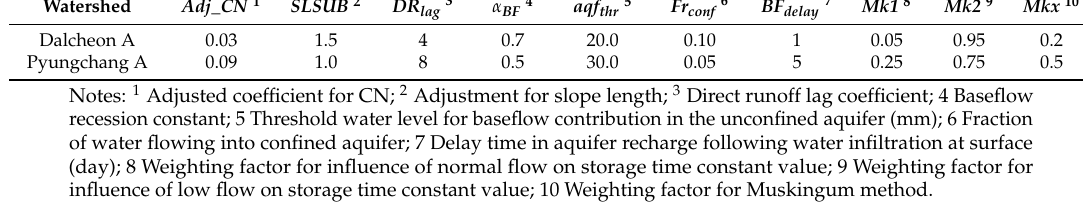
Table 5. Calibration parameters for streamflow component of the L-THIA ACN-WQ model. Watershed Adj_CN 1 SLSUB 2 DR lag 3 α BF 4 aqf thr